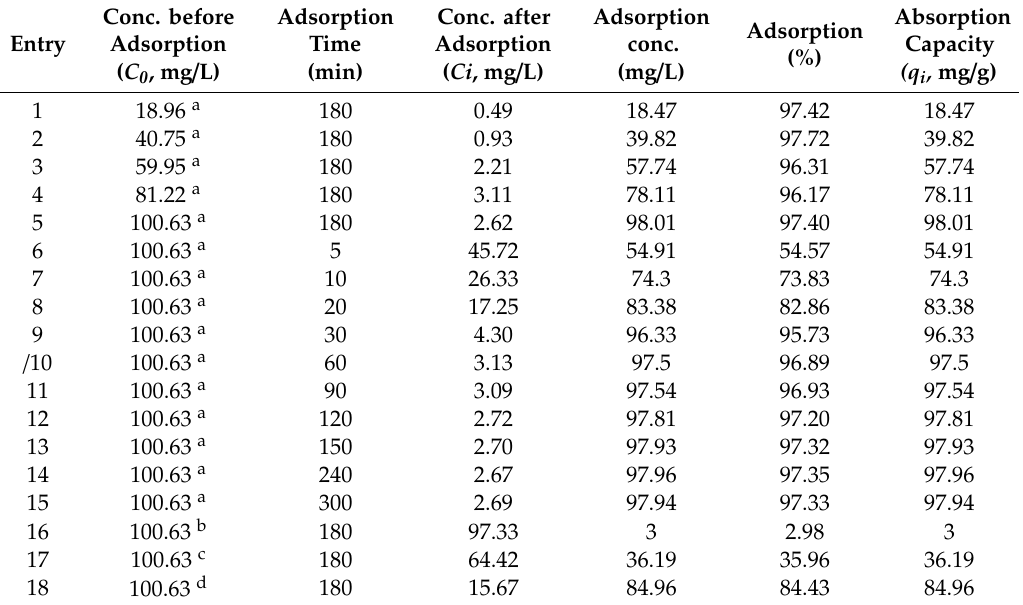
Table 1. Dynamic adsorption of copper ions by chitosan microspheres.